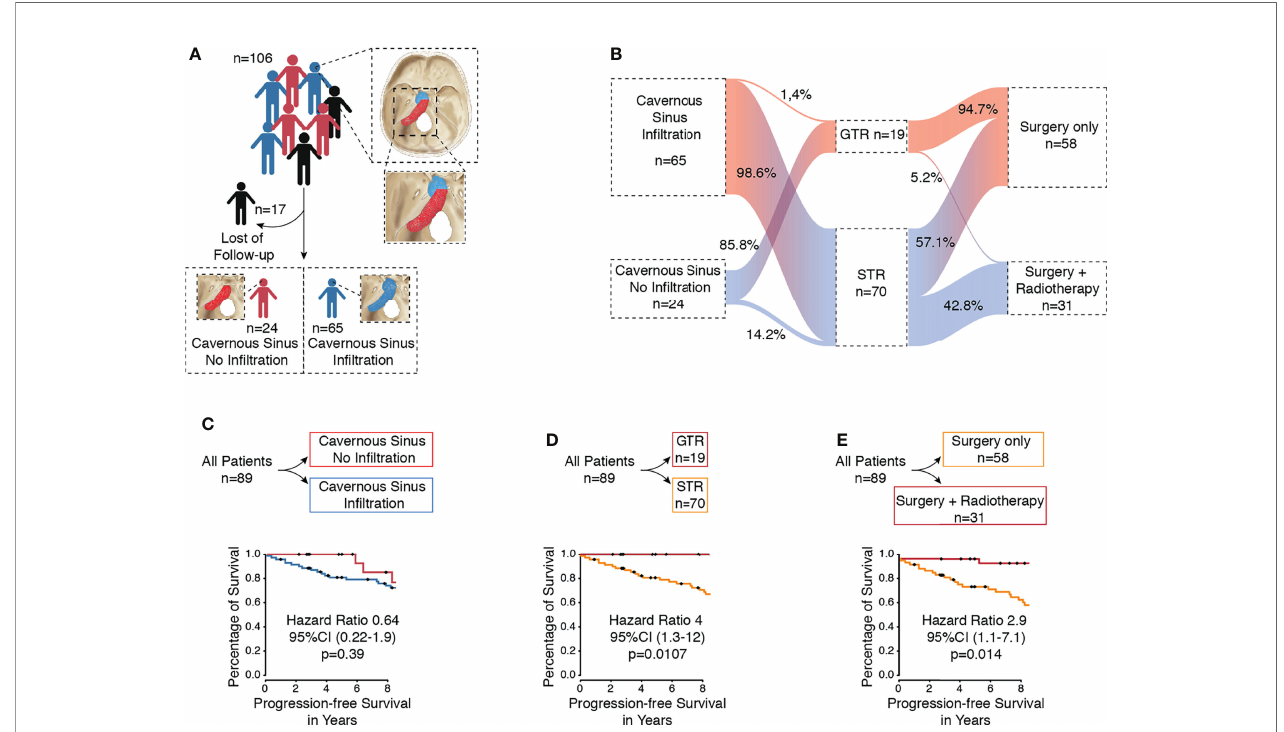
FIGURE 1 | (A) Flow diagram of included patients with petroclival meningioma from our database. (B) Flow diagram of the different treatment arms. (C) Kaplan – Meier curve of all patients for progression-free survival based on in fi ltration of cavernous sinus. (D) Kaplan – Meier curve of all patients for progression-free survival based on extent of resection (GTR vs. STR). (E) Kaplan – Meier curve of all patients for progression-free survival based on therapy (surgery vs. surgery plus